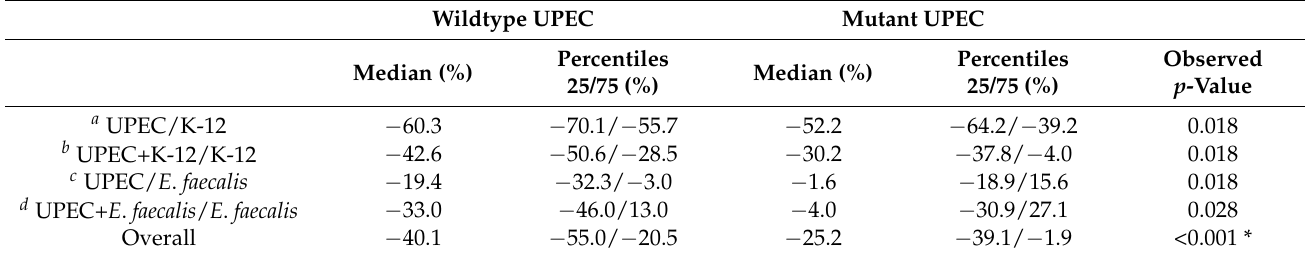
Table 3. Inferential evaluation of indices and related median, 25th, and 75th percentiles for the overall associations through the comparison of seven wildtype and mutant UPEC.